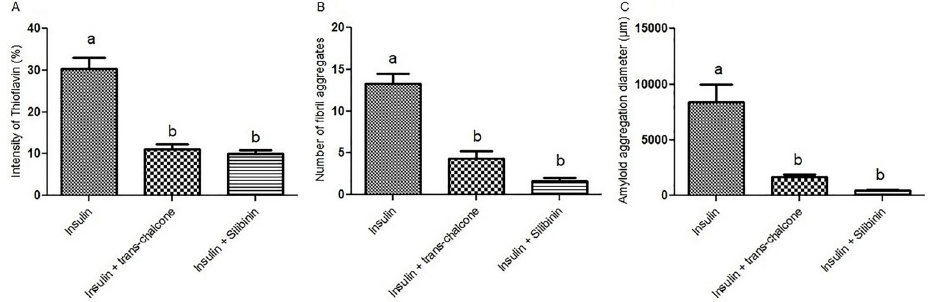
Figure 5. Quantitative analysis of Figure 4 data. Data are reported as the mean and standard error. Different letters indicate statistically signi fi cant differences (ANOVA). A , Intensity of thio fl avin S (%) in the presence and absence of trans- chalcone and silibinin, ( B ) number of fi bril aggregates in the presence and absence of trans- chalcone and silibinin, ( C ) amyloid aggregation diameter ( m m) in the presence and absence of trans -chalcone and silibinin.